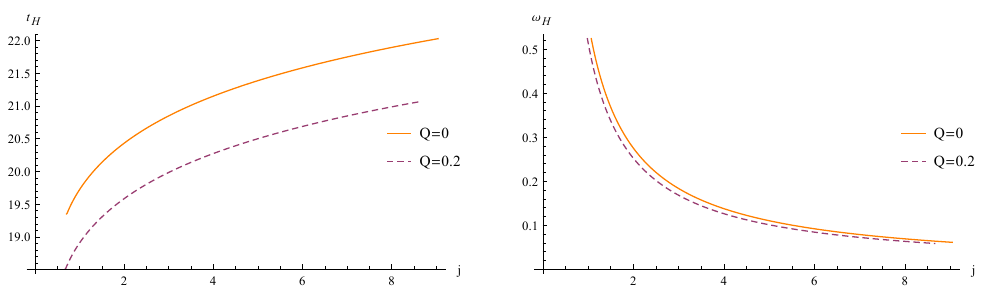
Figure 2 . The ( j; t H ) (left panel)and ( j; ! H ) (right panel) phase diagram of the large D black ring solution. The solid and dashed line correspond to the uncharged (Q=0) and charged case (Q=0.2)